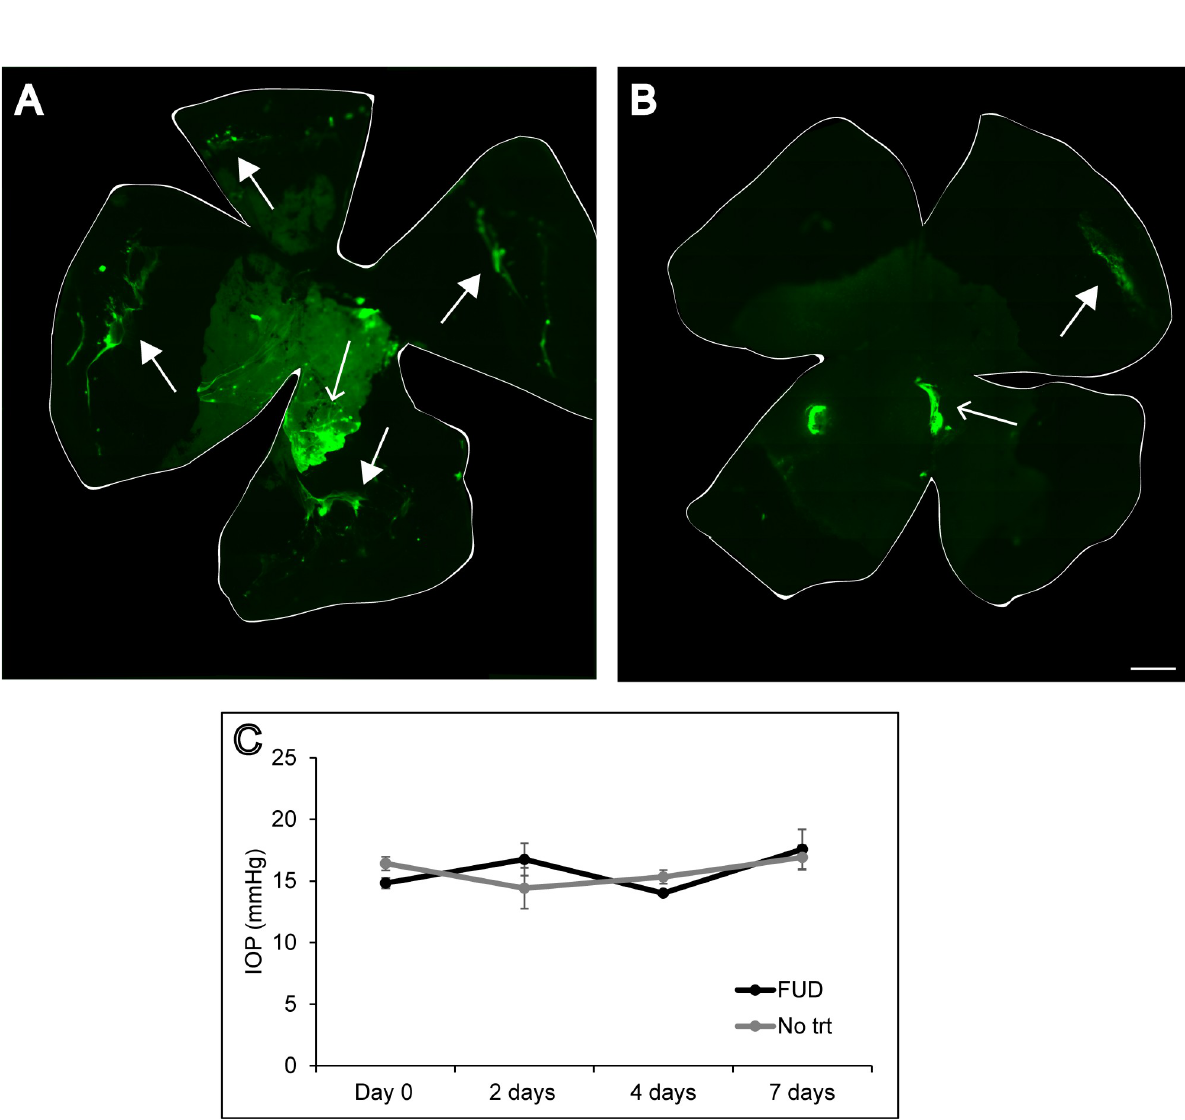
Fig 3. Alexa 488-conjugated FUD effect on IOP and localization in the eye. C57BL/6 mouse anterior segment whole mounts 4hours (A) or 3 days (B) after receiving Alexa 488-conjugated FUD. The perimeter of the whole mounts is indicated by the while lines. Arrows point to Alexa 488-conjugated FUD in the TM. Open arrows point to Alexa 488-conjugated FUD in the cornea. Bar = 500 μ m. (C) Graph shows IOP of C57BL/6 mice injected intracamerally with 1 μ M Alexa 488-conjugated FUD to one eye. The contralateral eyes (No trt) did not receive an injection. No points were statistically significant, n = 4 eyes. Data is shown as mean ± SEM of the IOP measured at that time point. Statistical analysis was performed using an unpaired Student t-test.